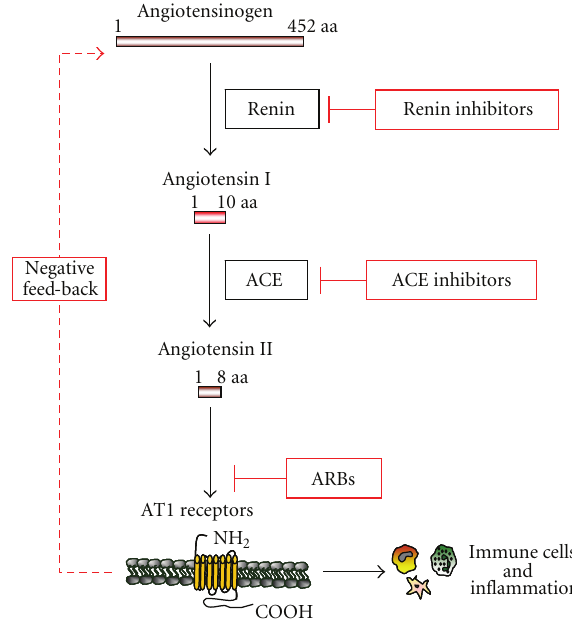
Figure 2: Simplified view of renin-angiotensin pathway and its pharmacological inhibition. Renin inhibitors, ACE inhibitors, and ARB modulate angiotensin activities in inflammatory processes. AT 1 receptors, which are expressed in immune cells, have been shown to trigger inflammatory